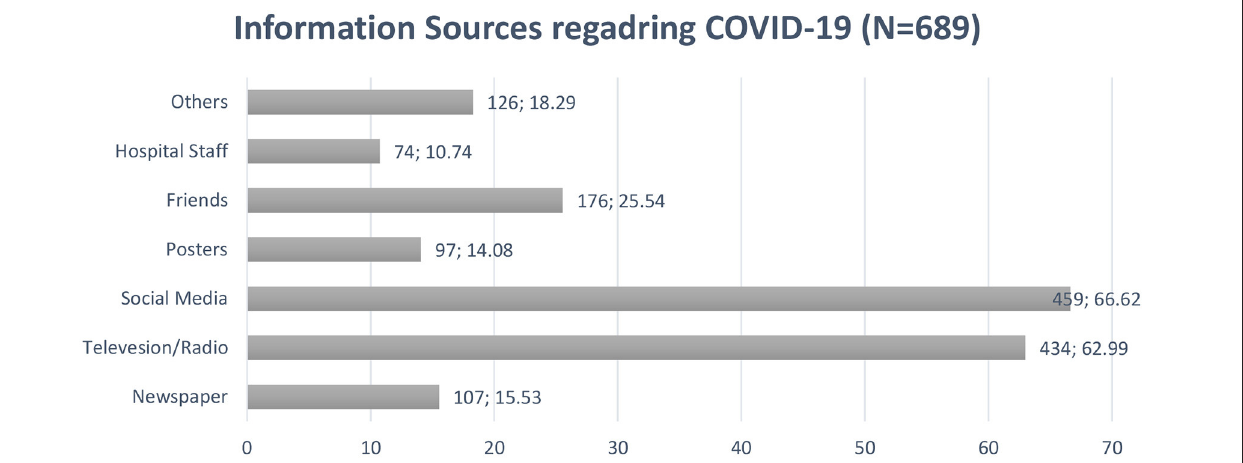
FIGURE 1 | Information sources utilized by public in